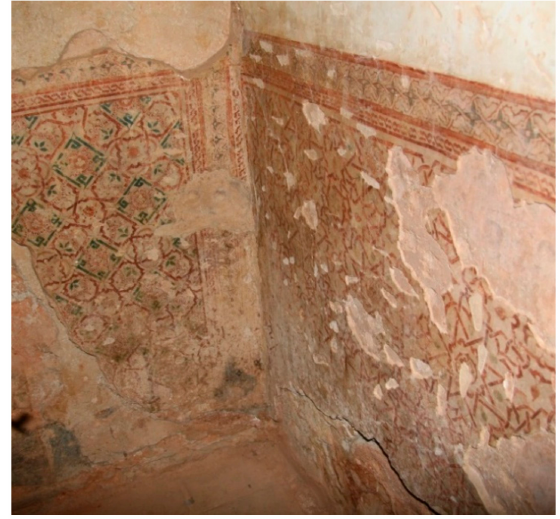
Figure 7. Painted dadoes from the Nasrid period from the western side of the latrine in the Hall of the